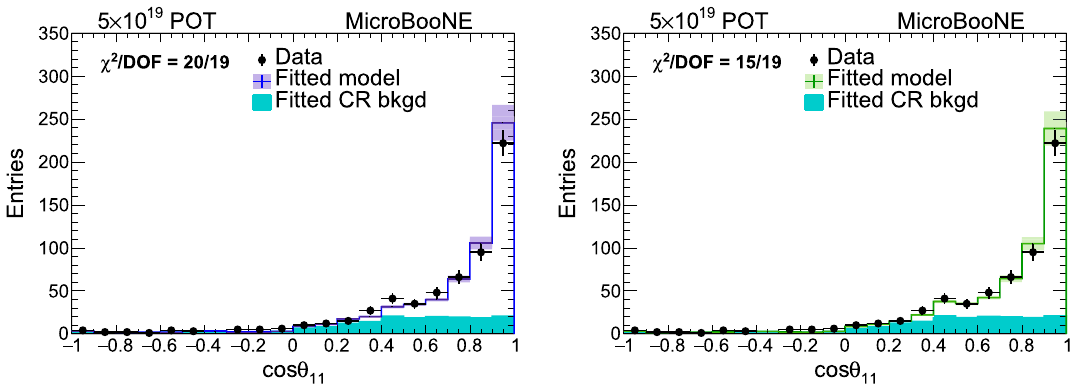
Fig. 16 Multiplicity = 1 candidate muon cos θ distribution using GENIE + MEC model (left); using GENIE + TEM model (right) from neutrino- enriched sample